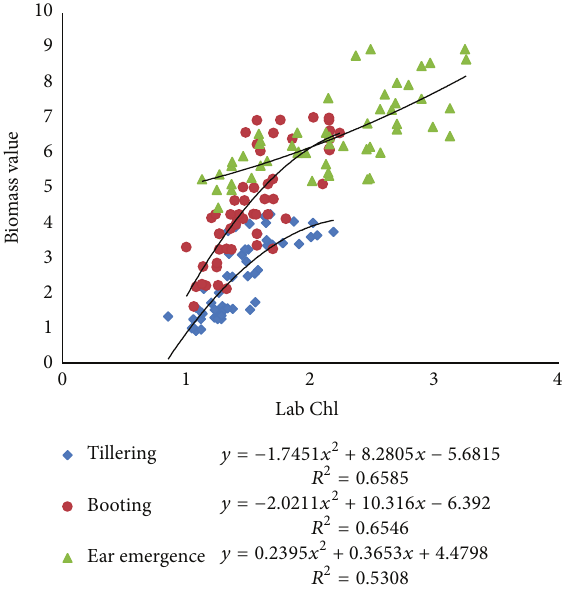
Figure 14: Correlations between sensor biomass values and Lab Chl at different crop growth stages.